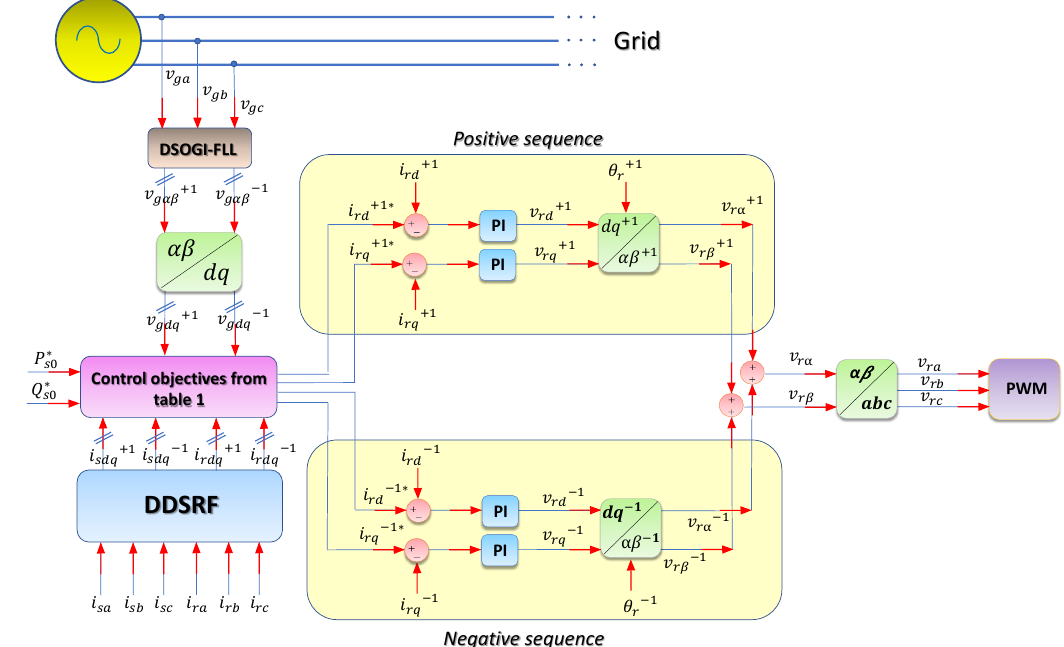
Figure 1. Alternative control proposed for the synchronous compensator. DDSRF: Double Synchronous Reference Frame; PWM: Pulse Width Modulation; PI: Proportional Integral; DSOGI-FLL: Double Second-Order Generalized Integrator Frequency-Locked